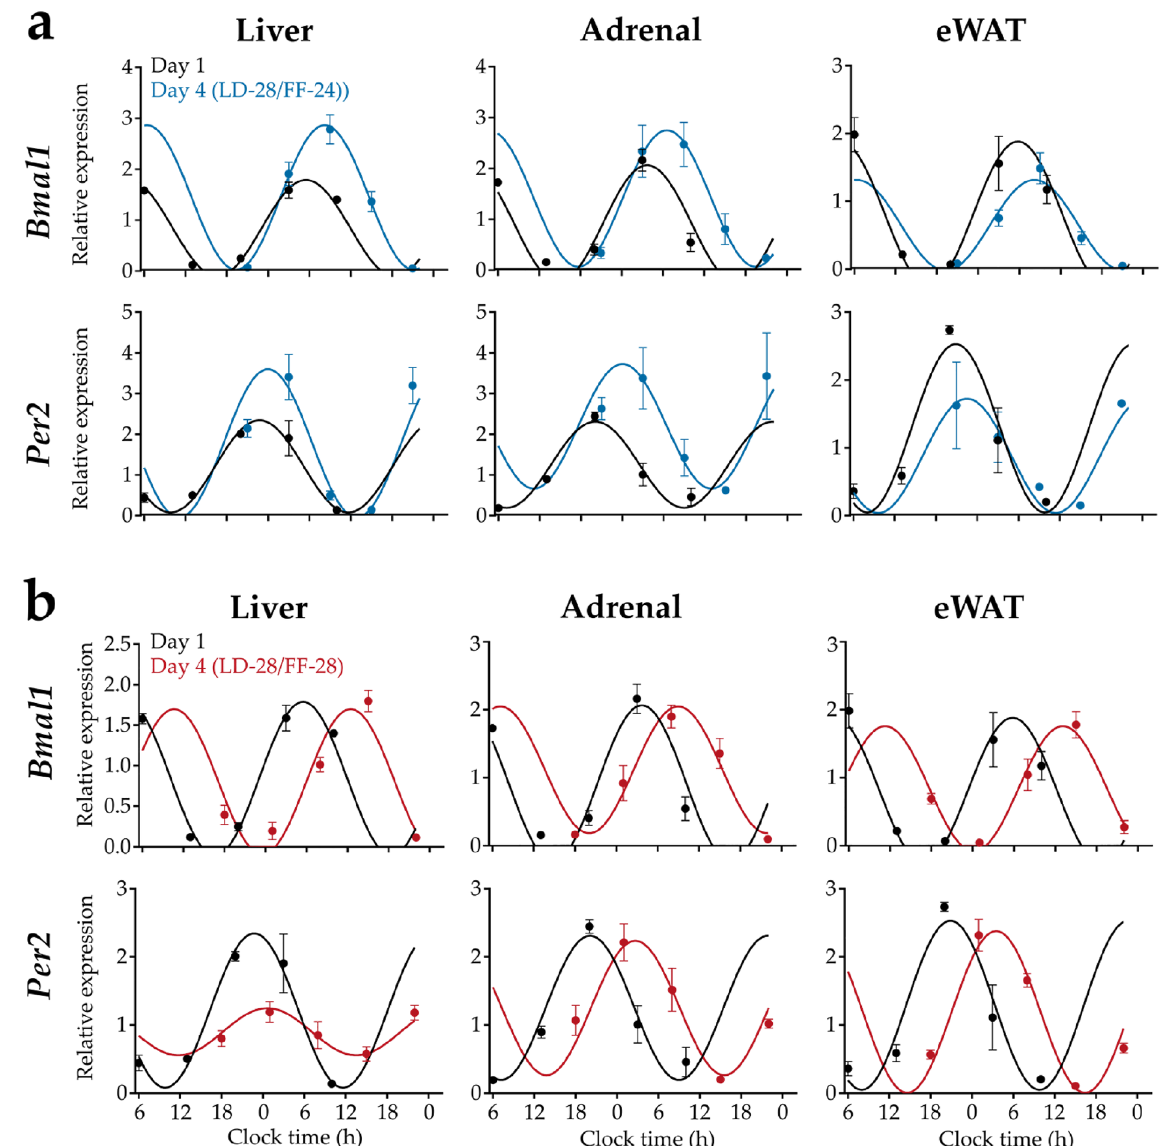
Figure 2. Clock gene expression profiles on the first and the fourth day under LD-28/FF-24 and LD-28/FF-28 conditions. Diurnal mRNA expression profiles over 28 h for Bmal1 (upper panel) and Per2 (lower panel) on days 1 (black) and 4 (blue, red) under ( a ) LD-28/FF-24 and ( b ) LD-28/FF-28 conditions in liver, adrenal, and epididymal white adipose tissue (eWAT; left to right). Data are shown as means ± SEM; n = 3–5 animals per time point. Fitted curves are sine waves with a wavelength of 25.8